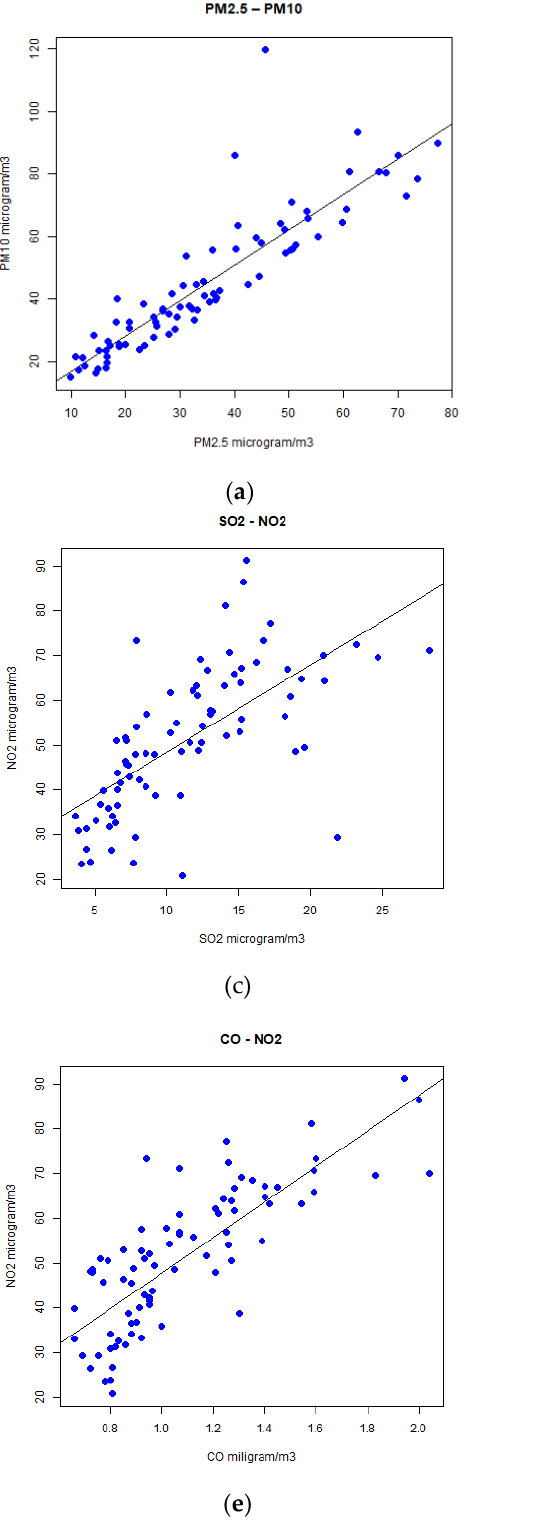
Figure 9. Linear regression diagrams created within R GUI with R program ( a ) PM10-PM2.5; ( b ) CO-NO; ( c ) SO 2 -NO 2 ; ( d ) NO-NO X ; ( e ) CO-NO 2 ; ( f ) NO 2 -NO X . Table 1. Summary statistics from linear regression model for PM2.5 and PM10.